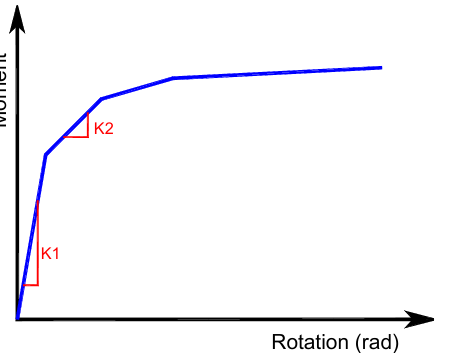
Figure 16. Anchor bolt arrangement according to moment direction.